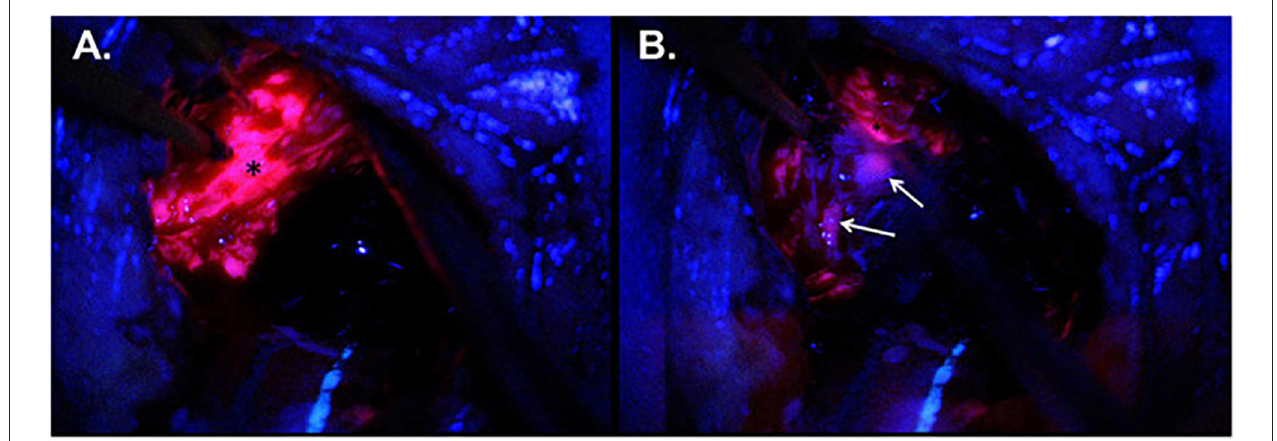
FIGURE 3 | Intraoperative imaging for case demonstration patient. (A) Tumor bulk fluorescence after 5-ALA administration (asterisk). (B) Infiltrative margin fluorescence after 5-ALA administration (white arrows). Taken with permission from Maragkos et al. ( 53).